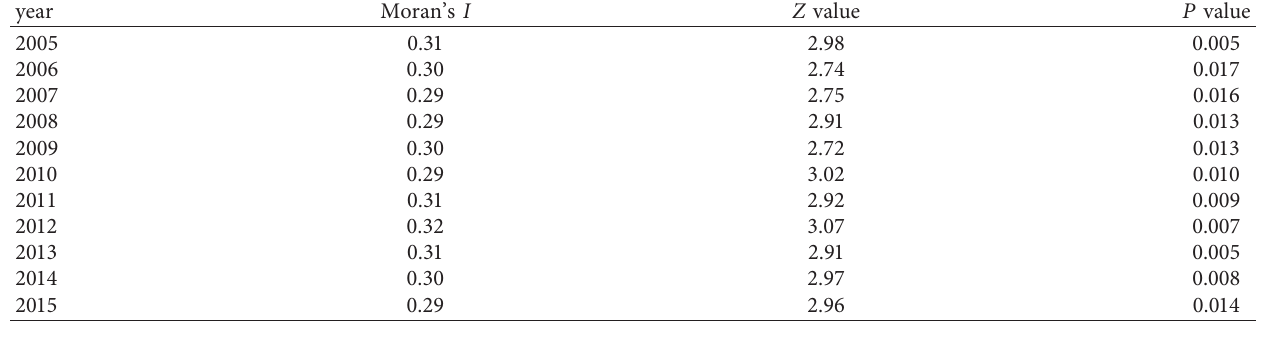
Table 2: Moran’ I value of GDP in Northeast China.